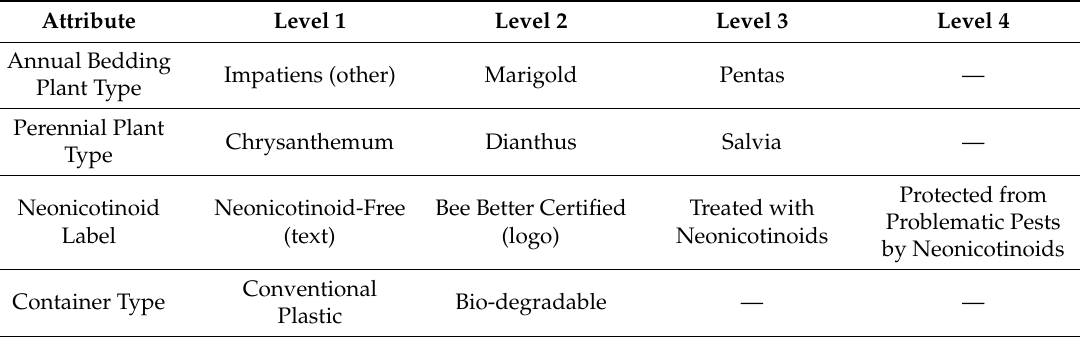
Table 1. Plant attributes and attribute